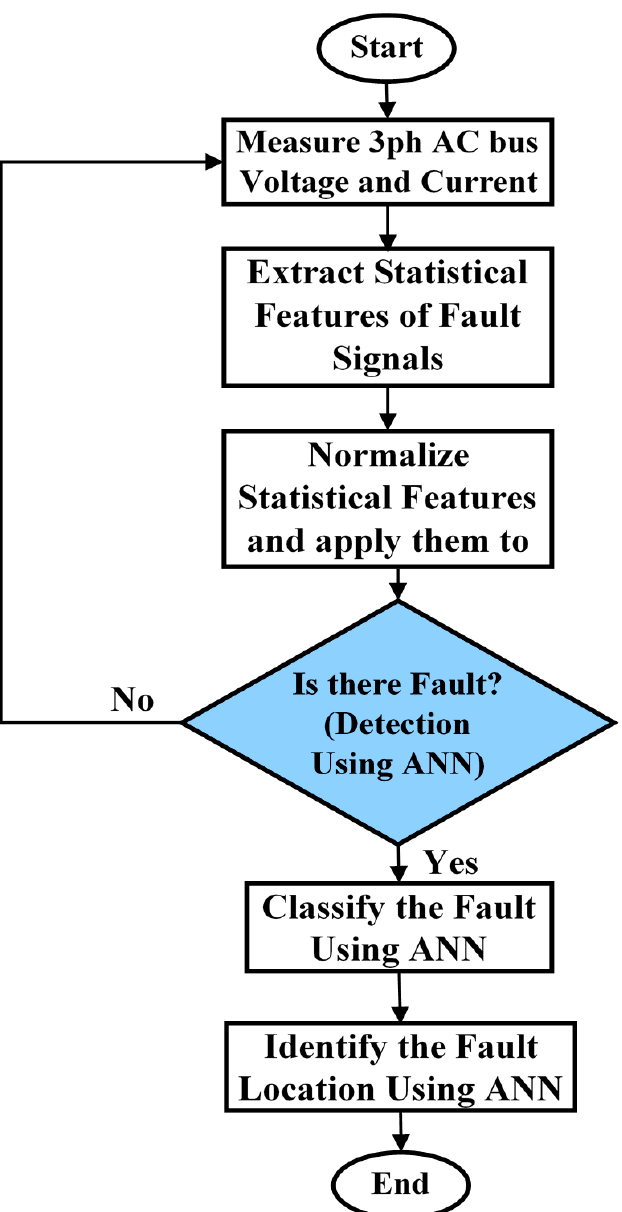
Figure 8. Flowchart for fault detection, classification, and location using Figure 8 . Flowchart for fault detection, classification, and location using ANNs.